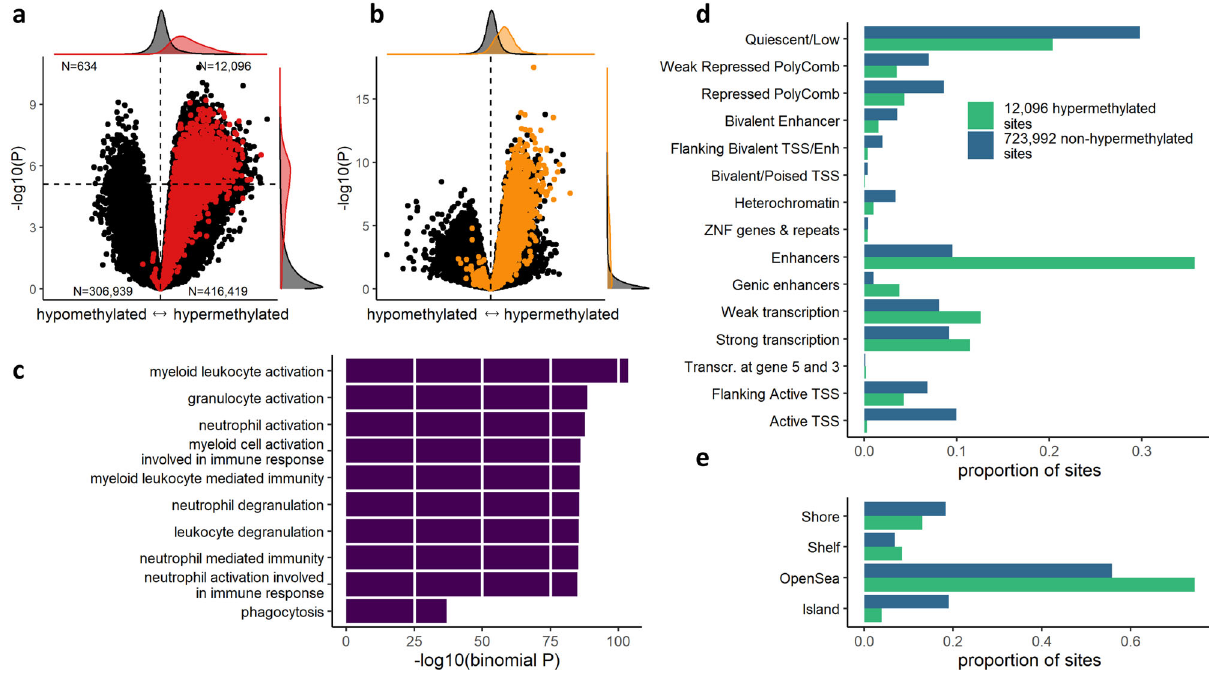
Fig. 3 Results of epigenome-wide analyses of TET2 mutations in granulocyte DNA from fi ve CCUS patients and eight healthy controls. a Volcano plot of CCUS results. Red dots indicate CpG sites from the set of 2741 hypermethylated sites in CHIP (Fig. 1c). Margins display distributions of the 2741 sites versus the rest of the EPIC array. Numbers in corners indicate the number of dots (both colors) in each quadrant separated by dashed lines. P values and effect size estimates derived using a linear model in Limma. P values are two-sided and not adjusted for multiple comparisons. b Volcano plot of CHIP results (same as 1C), yellow dots indicate CpG sites from the set of 12,096 signi fi cantly hypermethylated sites in CCUS granulocytes (upper right quadrant in panel a ). Only sites analyzed in both CHIP and CCUS are shown. P values and effect size estimates derived using a linear model in Limma. P values are two-sided and not adjusted for multiple comparisons. c Enrichment of Gene Ontology terms for 12,096 hypermethylated sites in CCUS. P values derived using the region-based binomial test in GREAT and are not adjusted for multiple comparisong. d Monocyte chromatin states for hypermethylated and non- hypermethylated sites. e CpG island relations for hypermethylated and non-hypermethylated sites.